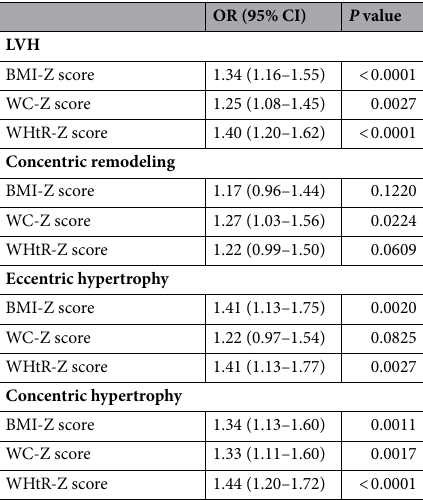
Table 2. ORs and 95% CIs of LVH and LVG according to different adiposity indexes in hypertensive youth. LVH, left ventricular hypertrophy; LVG, left ventricular geometry; BMI, body mass index; WC, waist circumference; WHtR, waist-to-height ratio. Logistic regression models were adjusted for systolic and diastolic blood pressure.